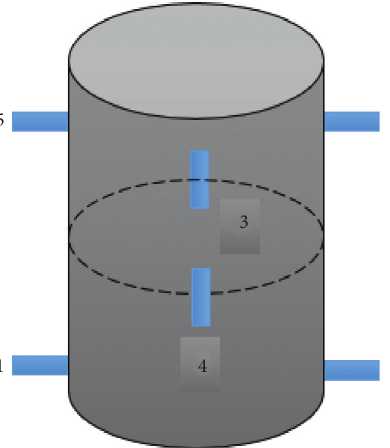
Figure 2: Layout of AE